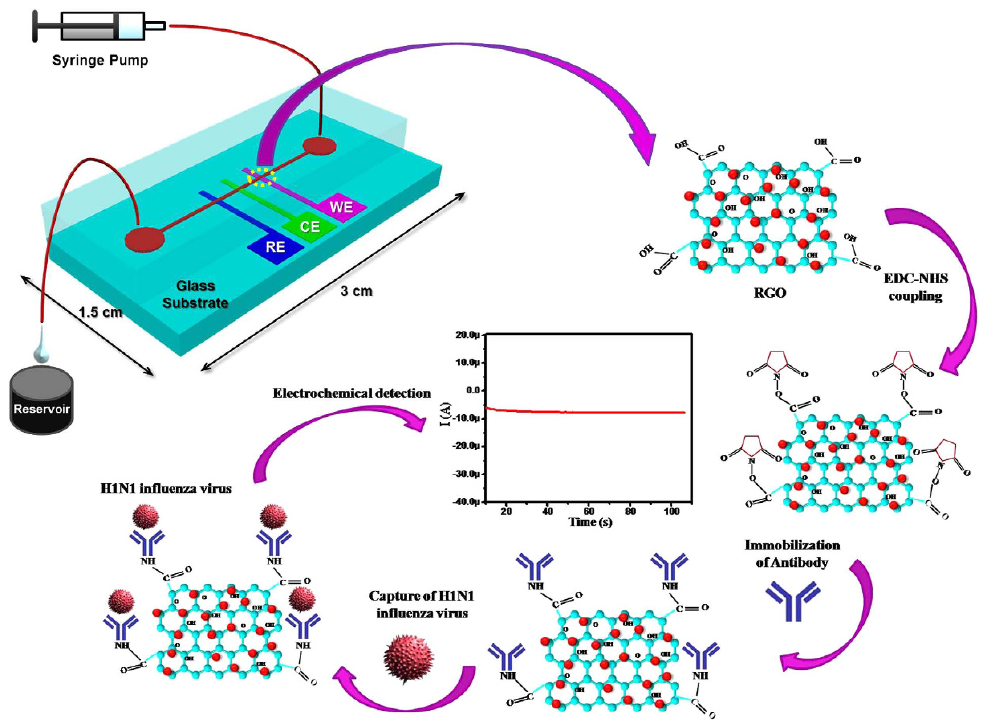
Figure 1. Schematic illustration of the microfluidics-integrated electrochemical immunosensing chip coated with RGO, followed by antibody immobilization using EDC/NHS coupling for the detection of influenza virus H1N1.